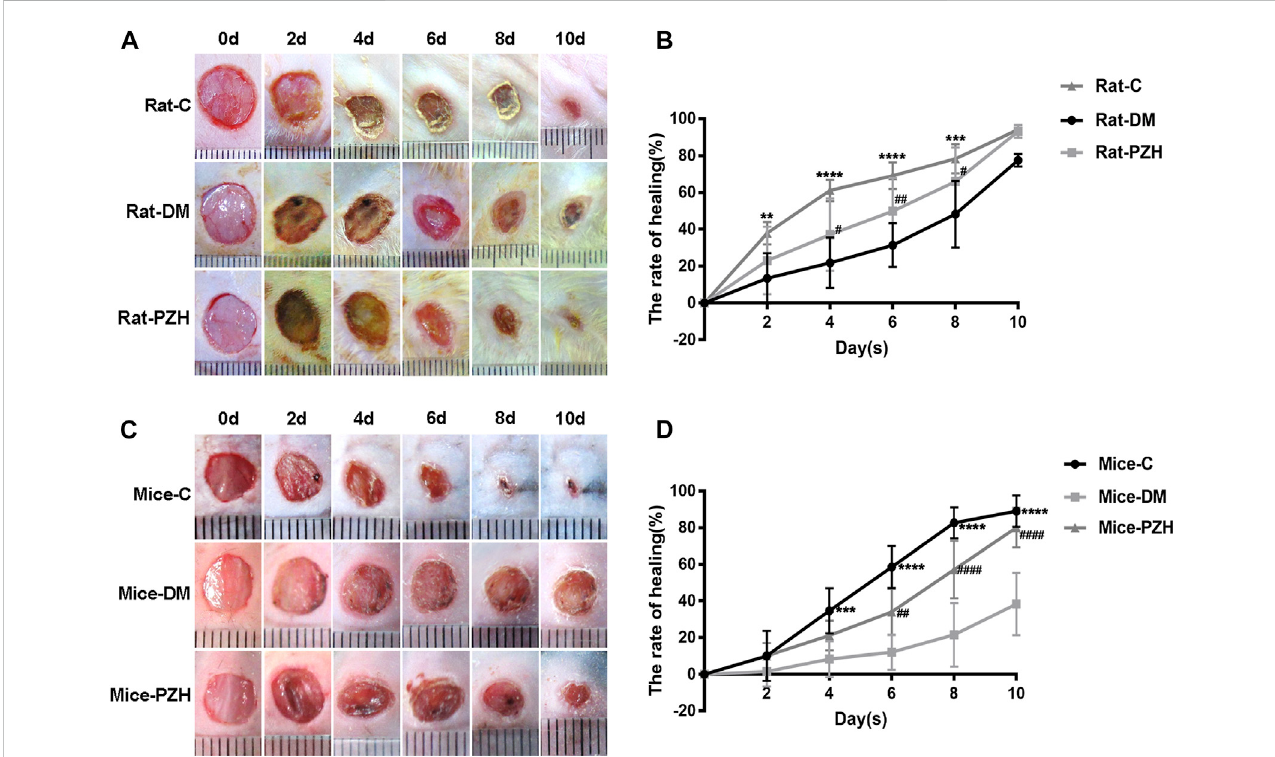
FIGURE 1 PZHpromoteswound healing indiabetesmodels. (A) Representative photos ofthewoundhealingprocessindifferentgroupsofrats. (B) Wound healing rate of different groups of rats. Data are expressed as the mean ± SD. C vs. DM: ** p < 0.01, *** p < 0.001, **** p < 0.0001 (n = 4); PZH vs. DM: # p < 0.05, ## p < 0.01(n=9). (C) Representativephotosofthewoundhealingprocessindifferentgroupsofmice. (D) Woundhealingrateofdifferentgroupsofmice.Cvs.DM: *** p < 0.001, **** p < 0.0001 (n = 6); PZH vs. DM: ## p < 0.05, #### p < 0.0001 (n = 6). C: normal control group, DM: diabetes model control group, PZH: diabetes model with PZH treatment